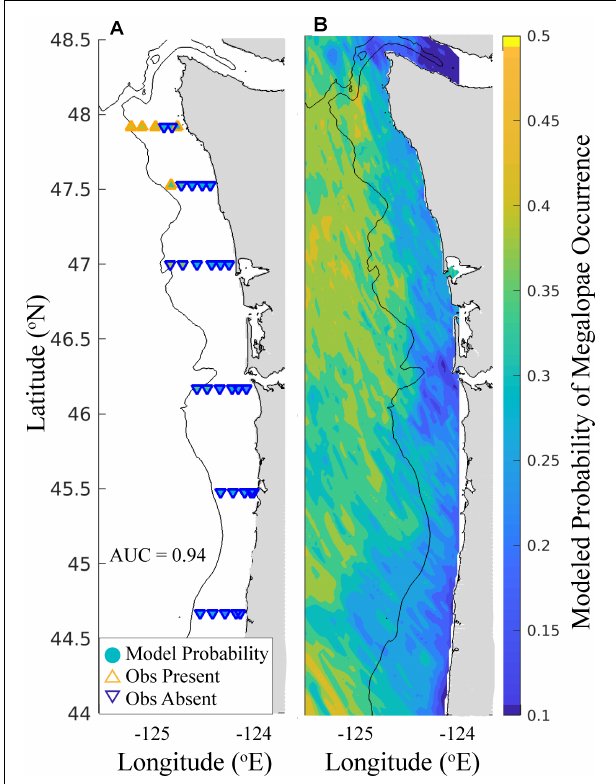
FIGURE 6 | Biological ensemble model forecast for the out-of-sample 2017 survey. (A) Comparison of ensemble-predicted and observed megalopae occurrence at 33 stations. Markers located at the megalopae sampling stations are filled (see color bar) according to the probability of megalopae occurrence as predicted by the biological ensemble (see Table 5 ). The outline color and orientation of the triangle indicates whether megalopae were observed to be present (orange, upward-pointing triangles) or absent (blue, downward-pointing triangles) at that station. (B) Probability of megalopae occurrence throughout the J-SCOPE x , y model domain forecasted by the biological ensemble (see color bar). Land is shaded gray, and the 200 m isobath is